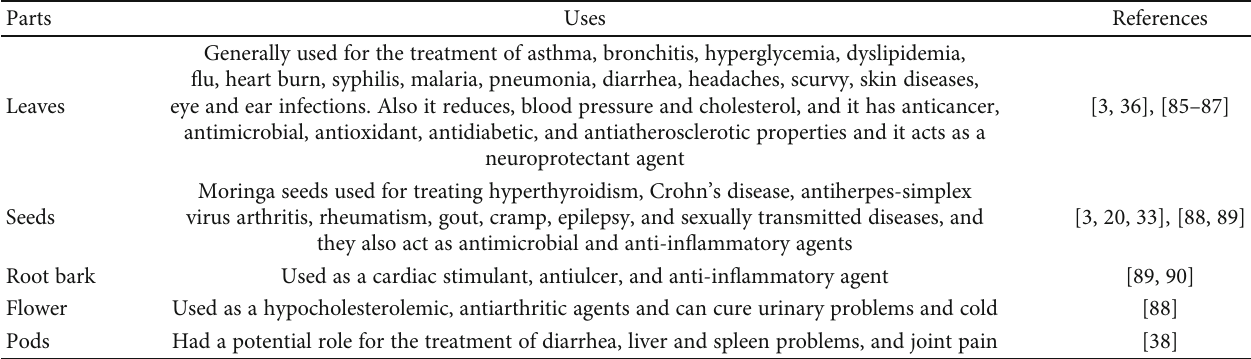
Table 8: Medicinal uses of di ff erent parts of the Moringa tree.